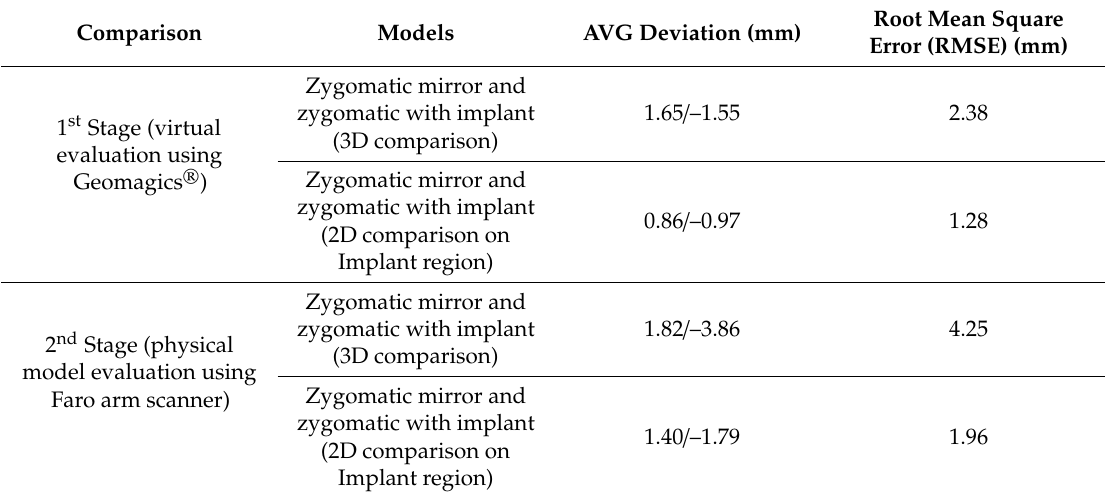
Figure 14. 3D measurement ( a ) Faro platinum arm with scanner; ( b ) scanning of the skull model fixed with titanium zygomatic implant. Table 2. 3D and 2D comparison results for implant accuracy evaluation.